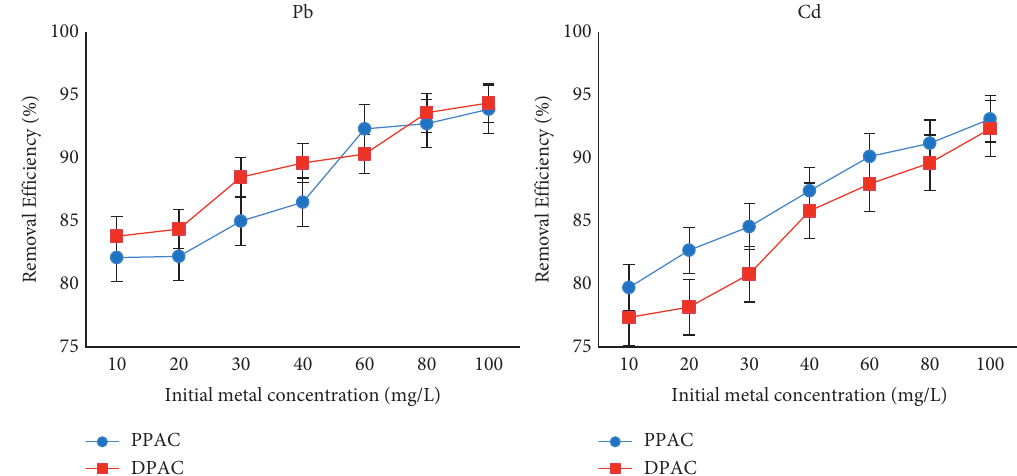
Figure 9: Effect of initial metal concentration on the adsorption of Pb(II) and Cd(II) (pH � 6, contact time � 90min, dose of DPAC � 1g/L, and dose of PPAC � 0.5g/L).